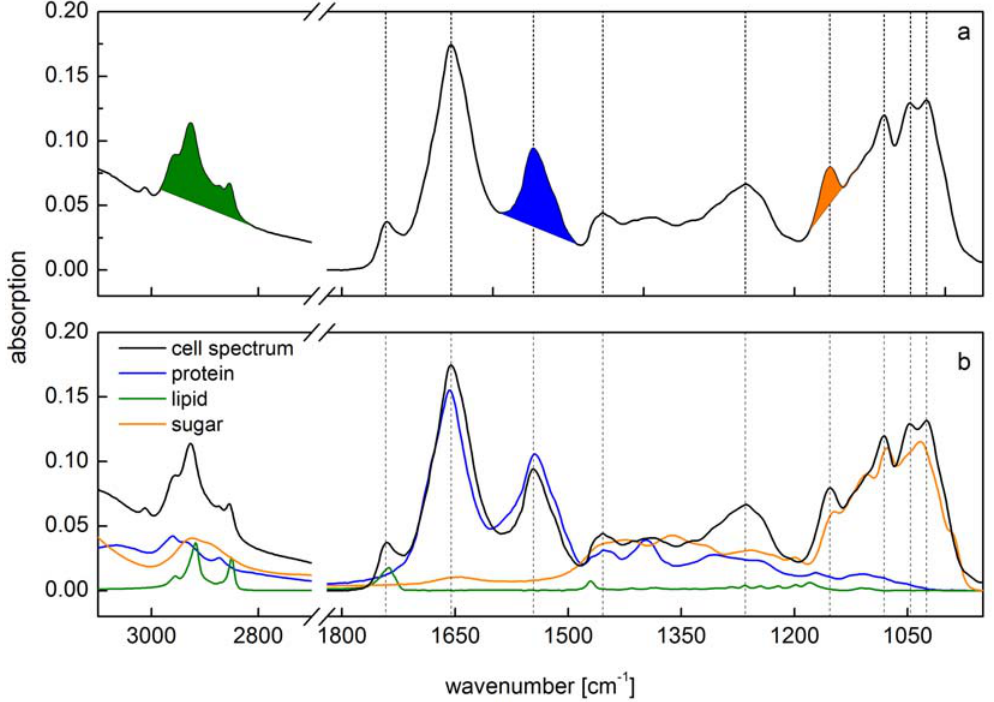
Figure 1. Comparison of two different methods for spectra interpretation. ( a ) Peak integral quantification of macromolecule contents [10]. Peak integrals have been marked (green: lipid; blue: protein; orange: carbohydrate); ( b ) Spectra reconstruction by reference spectra (green: lipid; blue: protein; orange: carbohydrate) of the same cell spectra according to [13]. Vertical lines indicate main peaks of the cell